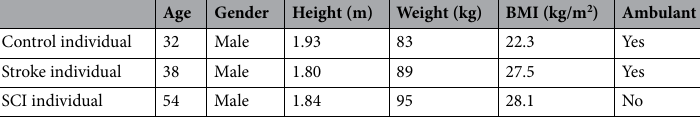
Table 1. Participant characteristics.